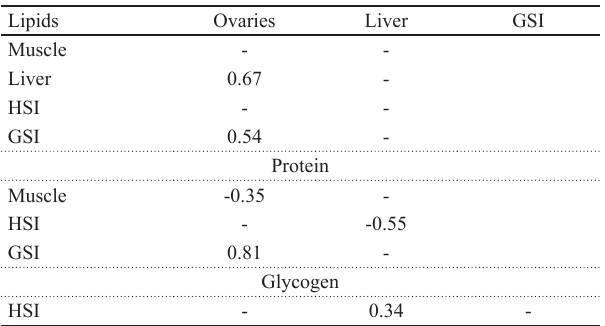
Tab. 2. Steindachneridion parahybae : Pearson correlation among metabolic parameters (total lipids, protein